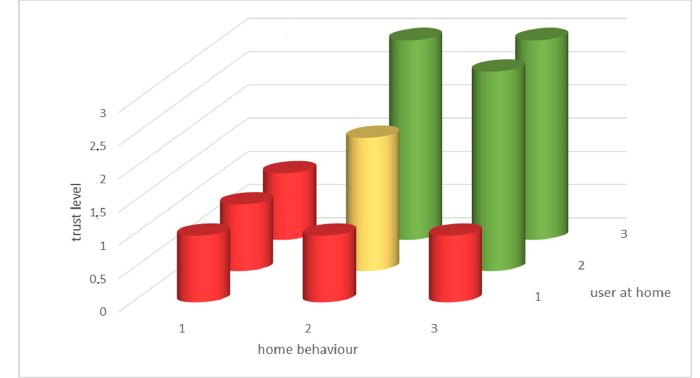
Figure 13. Trust level by location, device, and voice biometrics factors.